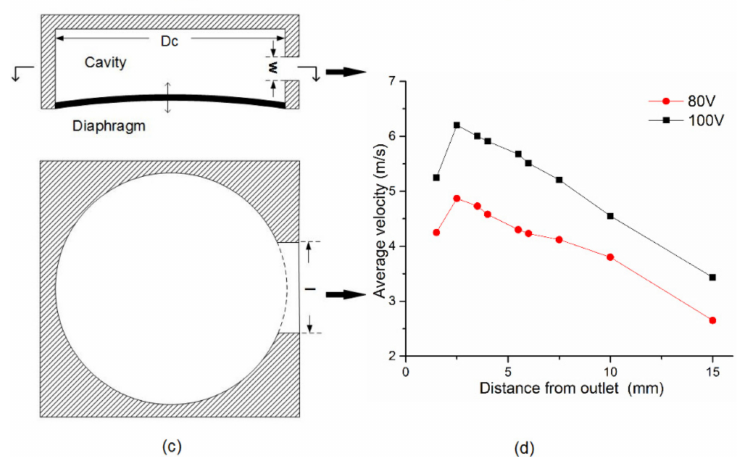
Figure 1. Schematic diagram ( a ) and installation photograph ( b ) of nozzle and actuators, actua- tor structure diagram ( c ), and actuator outlet centerline velocity distribution ( d